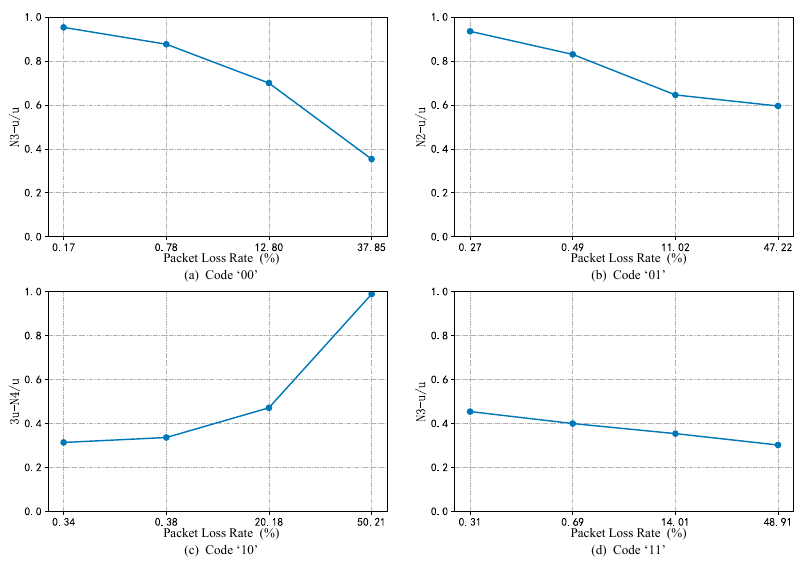
Figure 13. The Crps in the different packet loss rate in Figure 7c.